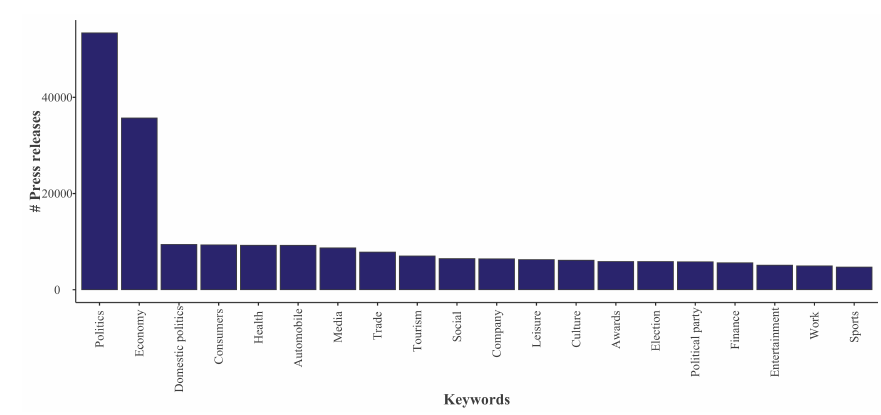
Figure 2: Most common keywords and frequency in press